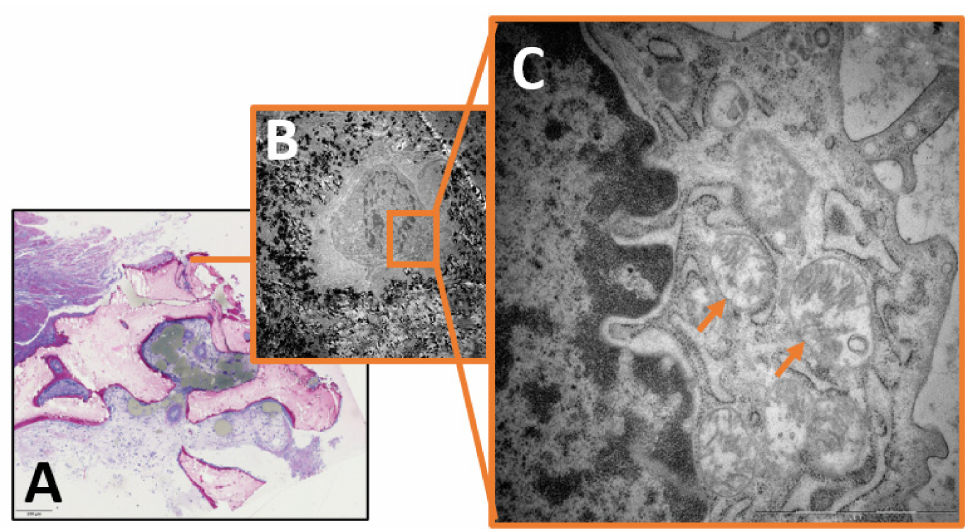
Figure 2. ( A ) Light microscopy image of infectious bone (Magnification × 40). ( B ) Magnification of ( A ). Transmission electron microscopy image of osteocyte from patient with osteomyelitis (Magni- fication × 5000). ( C ) Magnification of ( B ). Transmission electron microscopy image of perinuclear region of osteocyte. Visible cluster of swollen mitochondria with depleted cristae and reduced matrix density. Mitochondria exemplarily indicated by arrows (magnification ×